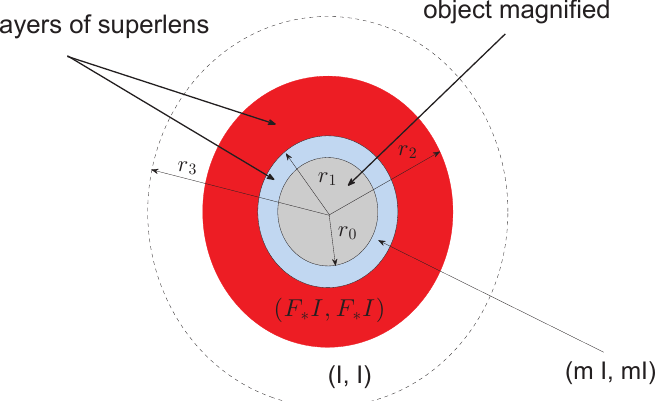
Figure 1: Lens contains two layers: the outer layer using NIMs is given by (1.3) , the inner layer is given by (1.4) .